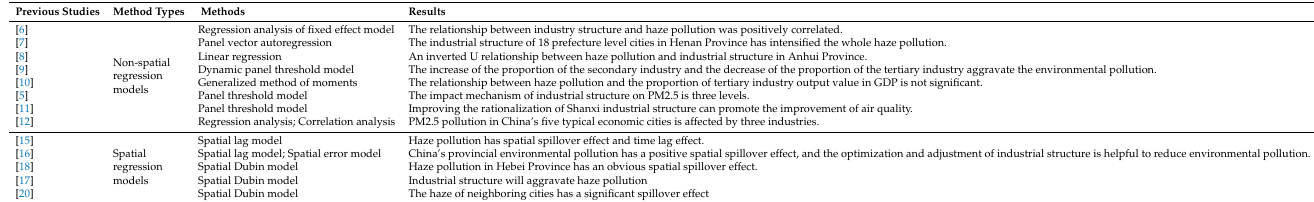
Table 1. Summary of previous research methods and